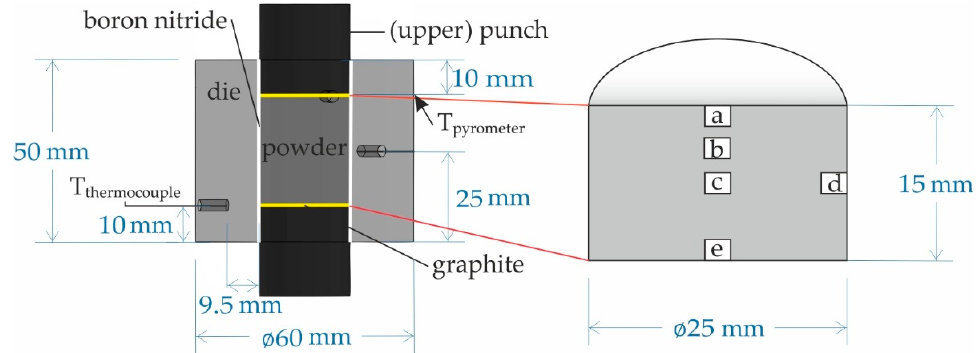
Figure 1. Experimental setup ( left ) and positions of morphology images a to e in the sample ( right ).